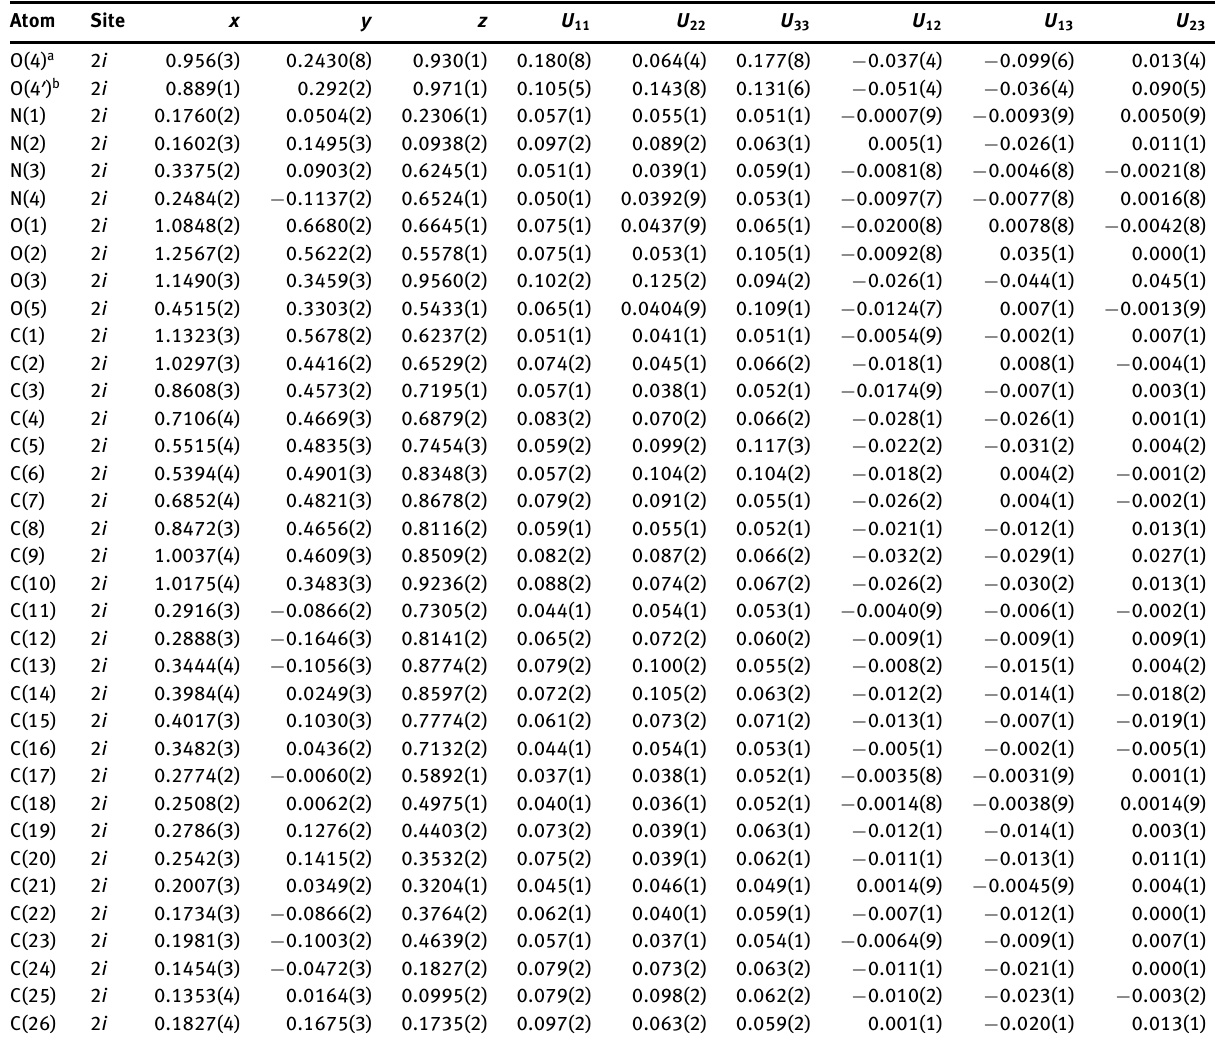
Table 3: Fractional atomic coordinate and displacement parameters (Å 2